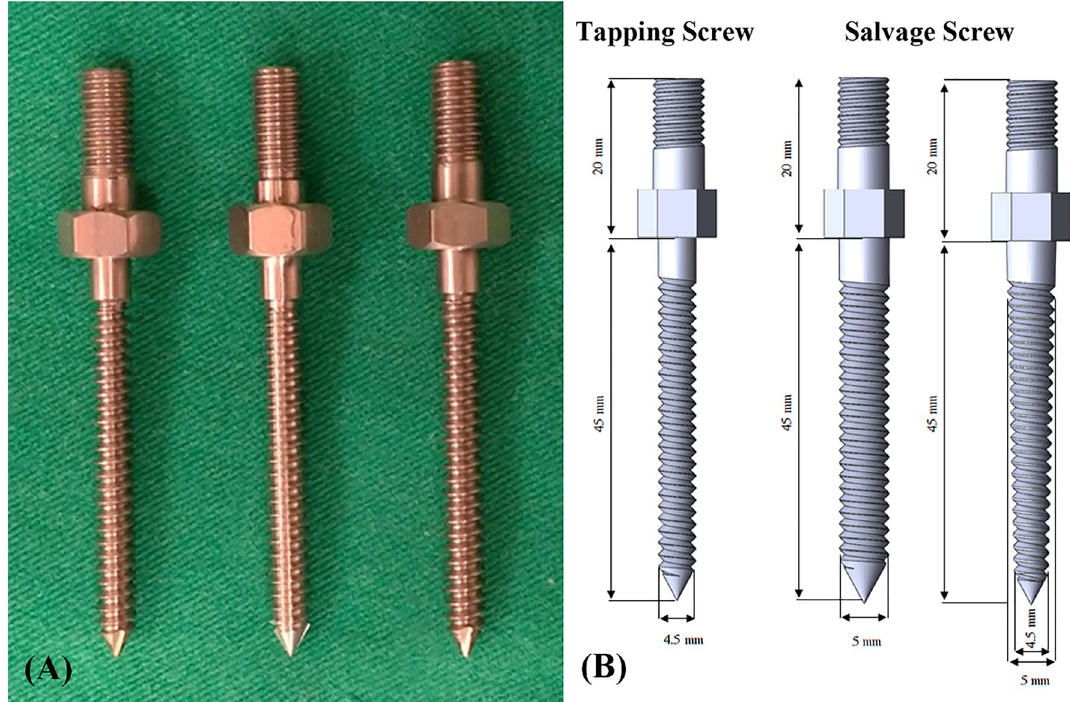
Figure 7. Salvage screws and tapping screw. Two salvage screw designs were employed in the present study: cylindrical and conical shaped ( A and B , middle and right). The outer geometry of the conical and cylindrical screws differed mainly in the taper of their major and minor diameters from the hub to the screw tip. The cylindrical screws maintained a constant diameter from hub to tip ( A and B , middle); in contrast, the conical screws tapered 10%, from 5.0 mm at the hub to 4.5 mm at the tip ( A and B , right). The tapping screw was cylindrical and maintained a diameter of 4.5 mm from hub to tip ( A and B , left). For all screw designs, the thread pitch was 2 mm and the thread depth was 0.8